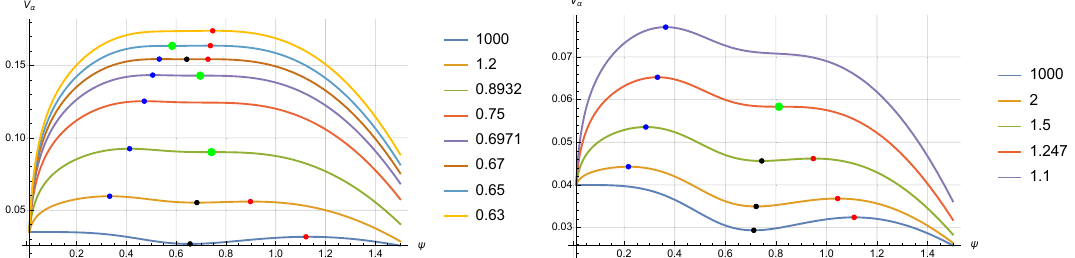
Figure 4 . On the left, we plot the non-extremal potential V as a function of ψ for p/ ˜ M = 0 . 035. α Different colors depict the potential at different values of the non-extremality parameter α . Once again, the blue dots indicate an unstable vacuum near the north pole ( ψ = 0) (fat M5 branch) and the black dots the metastable vacuum. The red dots indicate a second unstable vacuum (thin M5 branch). In this case there are three green dots. At α 0 . 8932 and α 0 . 6971 they represent (cid:30) (cid:30) merger points of a metastable state with a red unstable thin M5 state. At α 0 . 65 the green dot (cid:30) represents a merger with a blue unstable fat M5 state. On the right, we plot the non-extremal as a function of ψ for p/ ˜ M = 0 . 04. The plotted values of α are listed in the legend. In potential V α this regime there is a single green dot at α 1 . 247, which is a merger point of the black metastable (cid:30) state with the red unstable thin M5